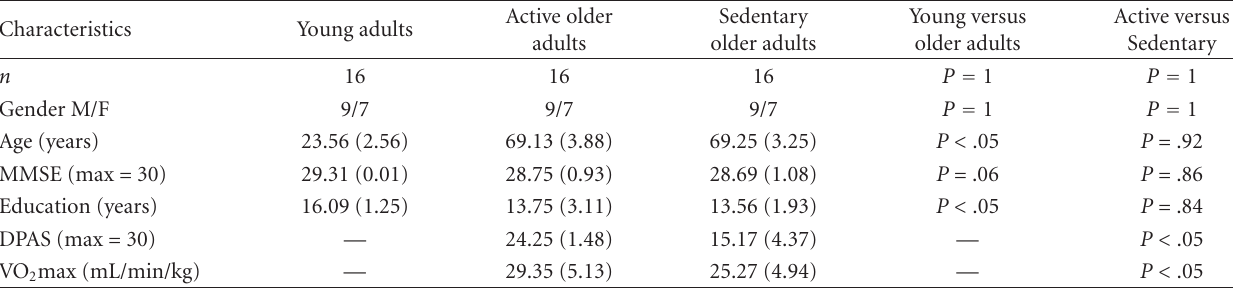
Table 1: Characteristics of the three groups of